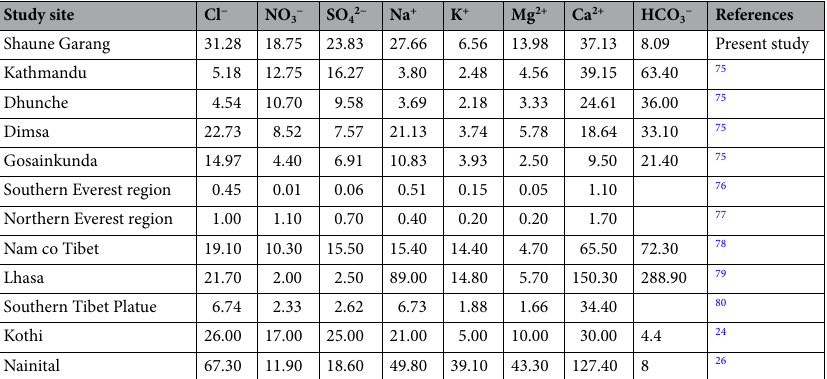
Table 2. The average chemical constituent of rainwater from Shaune Garang catchment and its comparison with a chemical constituent of rainwater from other high-altitude Himalayas (unit in